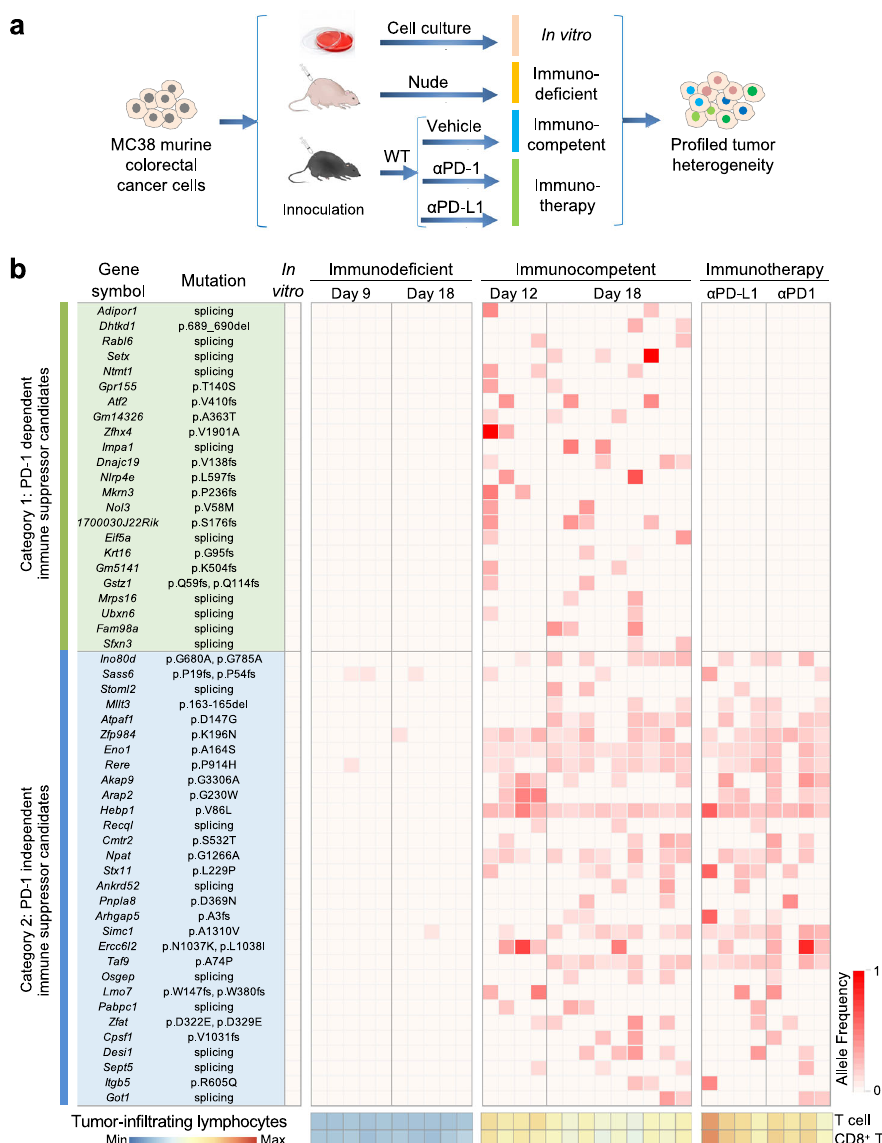
Fig. 1 Clonal mutation pro fi ling of tumors under progressive immune selection. a Schematic overview of clonal mutation pro fi ling of MC38 cell line- derived tumors grown in host mice harboring different levels of T cell immunity. b Heatmap showing allele frequency (AF) of hotspot mutations enriched (AF > 0.1) in at least two different tumors from the immunocompetent group ( n = 10 mice for immunode fi cient, n = 13 for immunocompetent, and n = 8 for immunotherapy group). A total of 59 mutations in 53 genes were categorized to PD-1 – dependent and – independent groups as indicated. Tumor-in fi ltrating lymphocytes were calculated by mMCP counter. See also Supplementary Fig. 1. Source data are provided as a source data fi